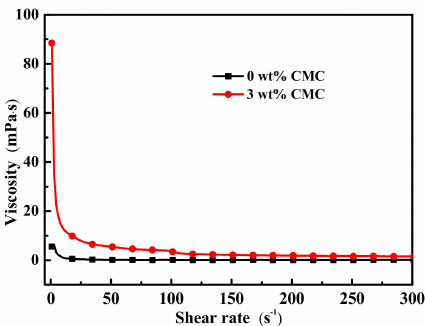
Figure 9. Viscosity curves of SAT / 5 wt.% DSP and SAT / 5 wt.% DSP / 3 wt.% CMC at 80 ◦